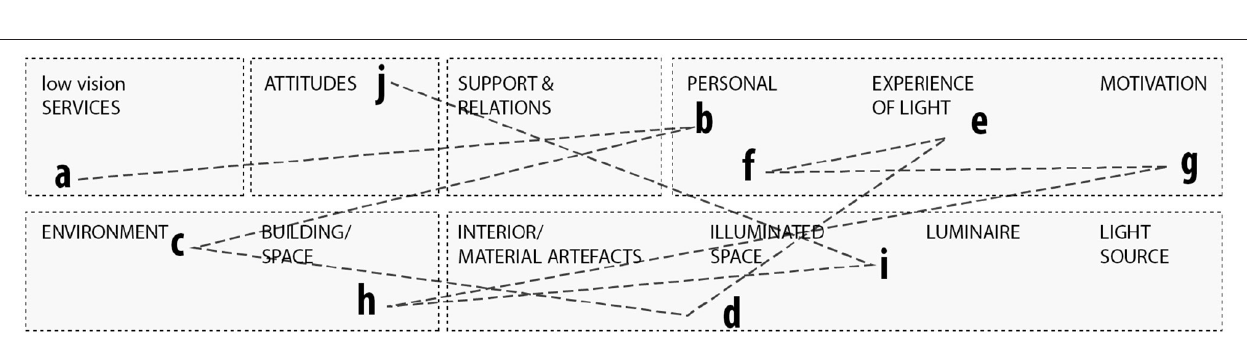
FIGURE 2 | Mapping of the physical parameters and its corresponding classification codes in ICF.